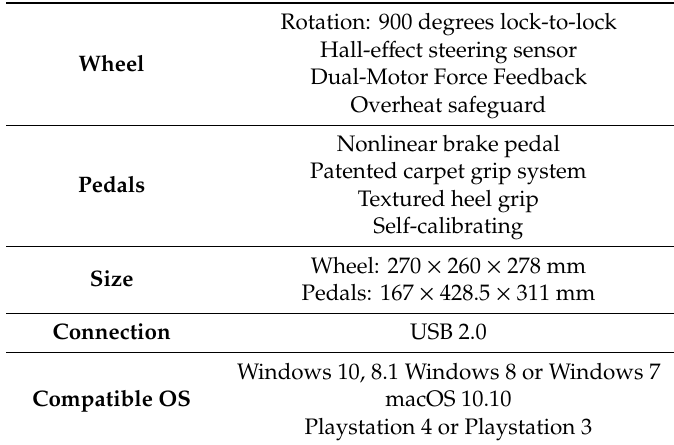
Table 5. Specifications of the G29. Data from